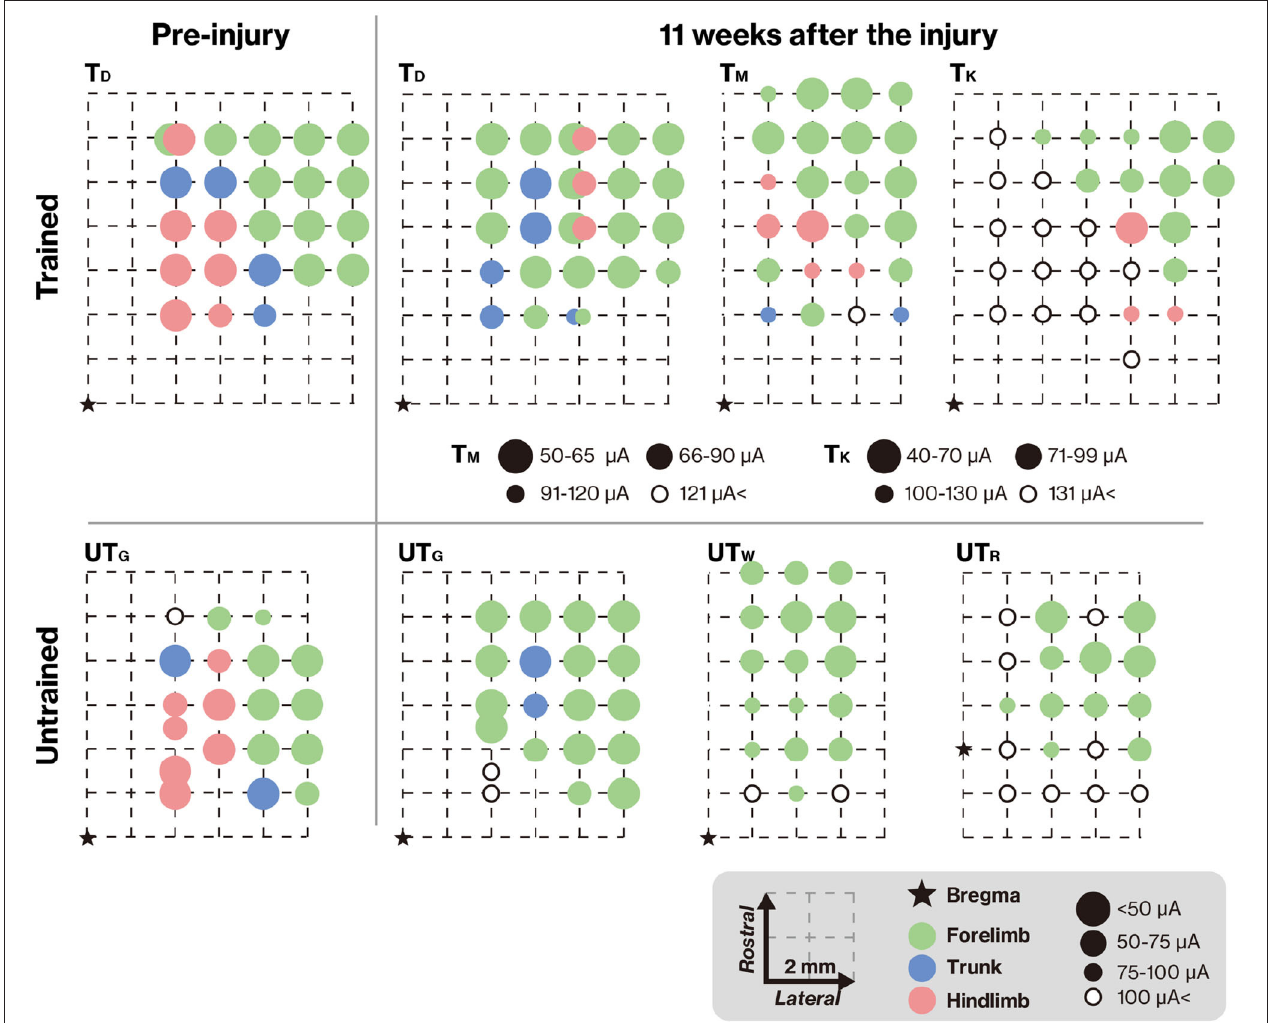
FIGURE 5 | Training-induced changes in the topographic map. The topographic map represents the electrode penetration sites. The corresponding positions of the electrodes are displayed as colors indicating the body territory activated under the lowest intracortical microstimulation (ICMS) current that still causes a movement. The results show that hindlimb movements could be evoked at positions close to the bregma in both T D and UT G (left column). Pre-injury ICMS maps are shown in the right panel. The hindlimb areas in the trained group remained unchanged (upper panel), but after the lesion, the hindlimb areas on the cortical surface in the untrained group were diminished (lower panel). In both groups, the M1 forelimb areas remained after the lesion. Note that different intensities were used for T M and T K